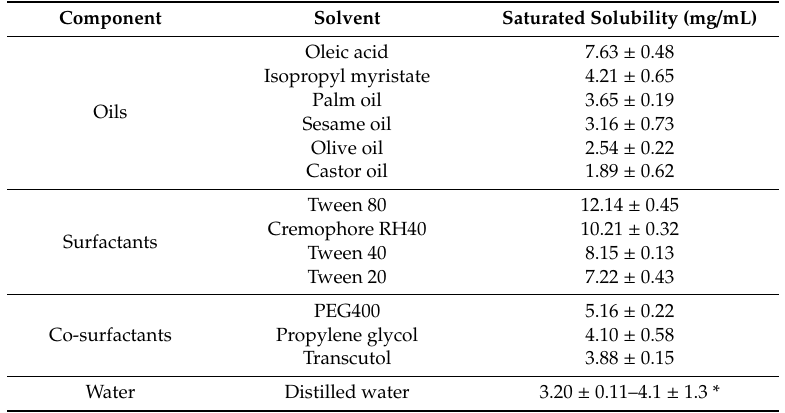
Table 2. Saturated solubility of sildenafil citrate in di ff erent solvents at room temperature (27 ◦ C ± 2 ◦